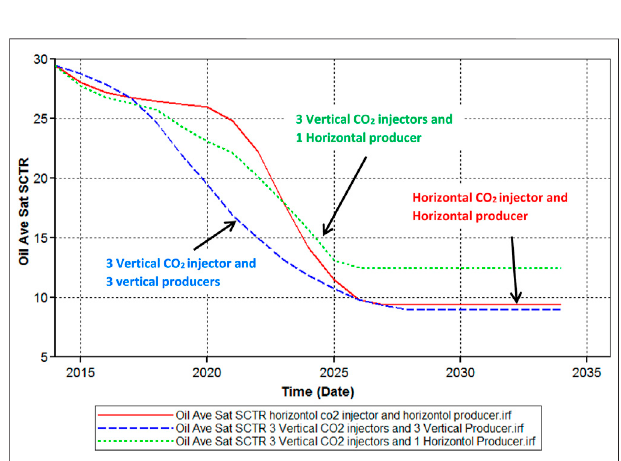
FIGURE 7 | Average oil saturation against time for the three examined cases. CO 2 was injected into the aquifer for all cases.